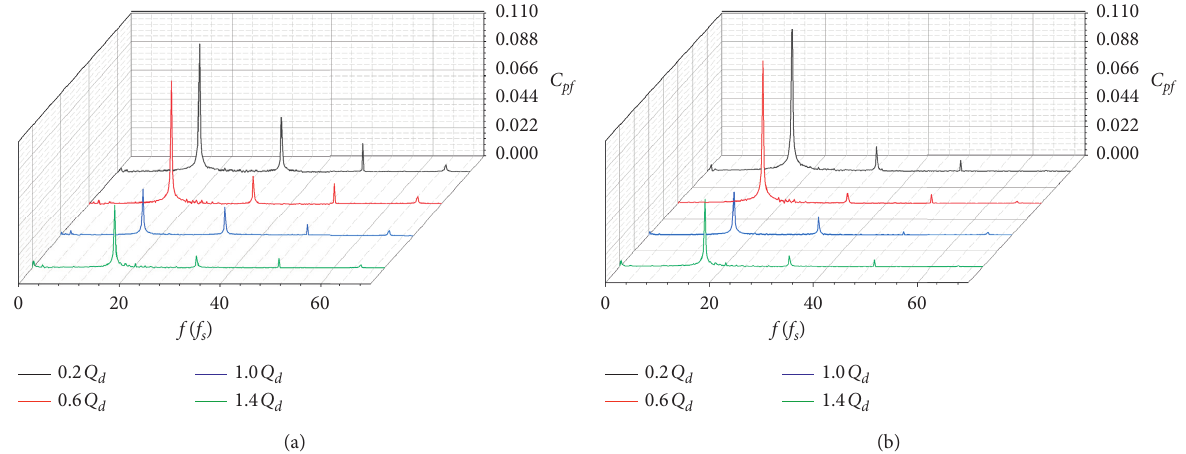
Figure 11: Pressure spectra at the tongue area for monitors: (a) 3 and (b)